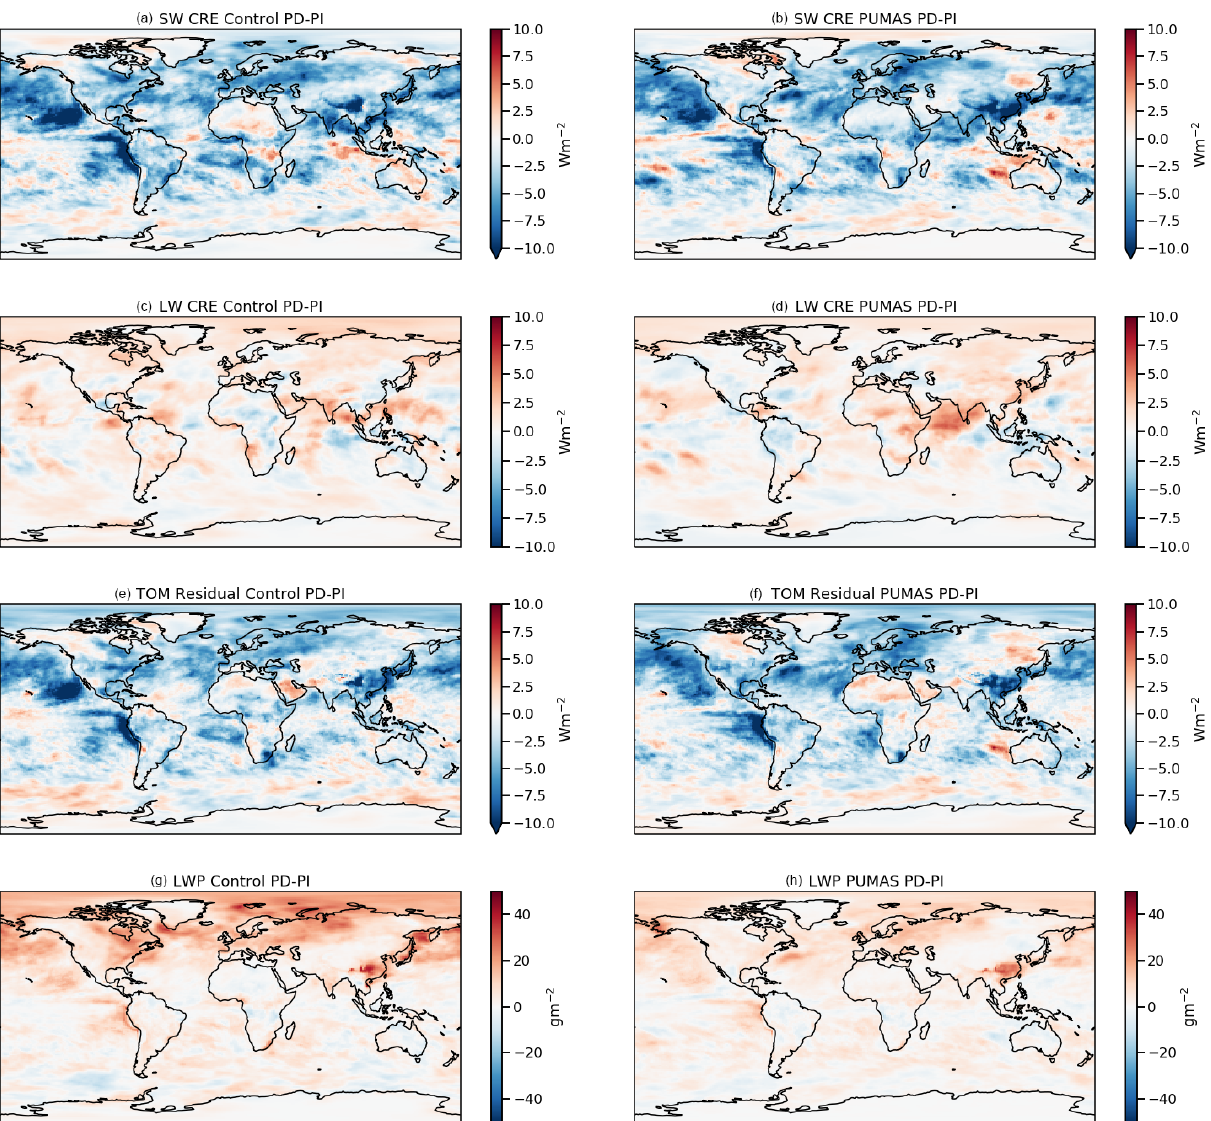
Figure 10. Differences between present-day (PD) and 1850 aerosol (PI) simulations for control (a, c, e, g) and PUMAS (b, d, f, h) . Variables shown are the (a, b) SW cloud radiative effect (SW CRE), (c, d) LW cloud radiative effect (LW CRE), (e, f) RESTOM balance, and (g, h) liquid water path